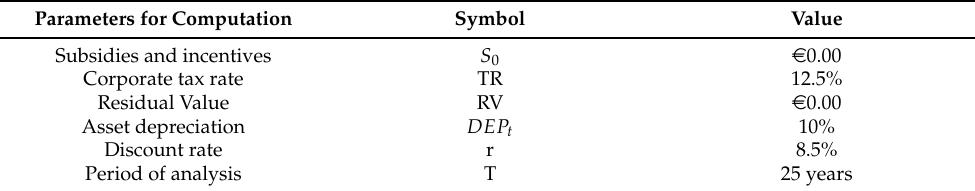
Table 3. Parameters for the levelized cost of heat. Parameters for Computation Symbol Value Subsidies and incentives S